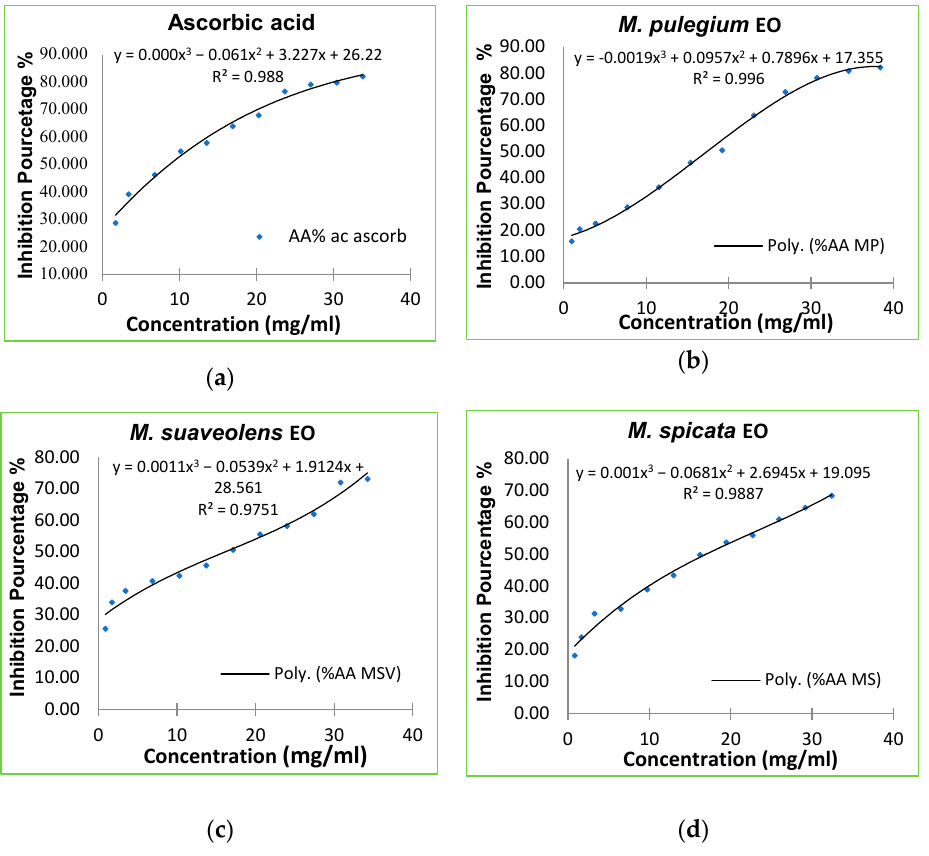
Figure 4. ( a ) Inhibition percentage of DPPH • according to ascorbic acid concentrations; ( b ) inhibition percentage of DPPH • of M. pulegium EO; ( c ) inhibition percentage of DPPH • of M. suaveolens EO; ( d ) inhibition percentage of DPPH • of M. spicata EO.